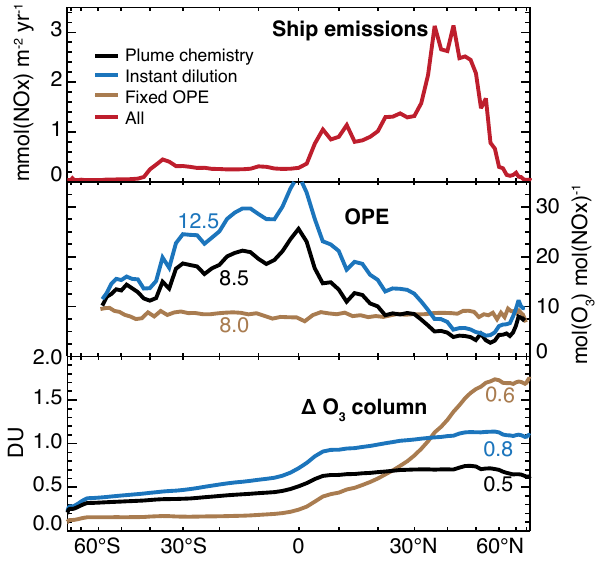
Figure 3. Annual- and zonal-mean NO x emission and ozone changes caused by maritime shipping plotted against sine latitude for each plume dilution assumption. OPE is averaged over regions where ship NO x emissions exceed 10 4 molecm − 2 s − 1 . Ozone col- umn changes ( 1 O 3 ) are calculated from 5% perturbations to full ship emissions, then multiplied by 20. Inset numbers give global averages.